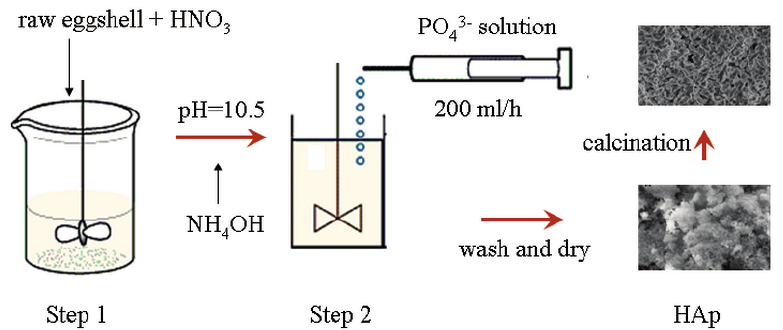
Figure 6. Illustration for the preparation of